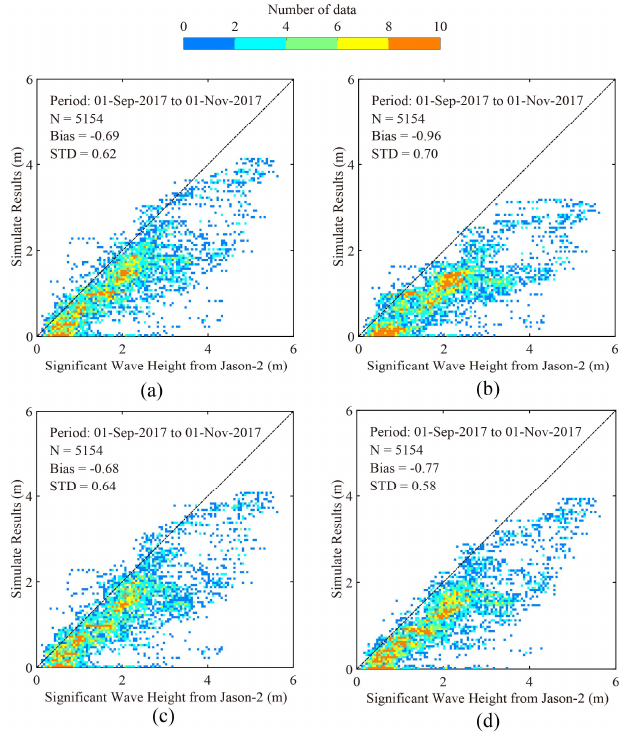
Figure 7. The comparisons between simulated results and measurements from altimeter Jason-2, in which the color represents the amount of data points. ( a ) Simulated results using the DIA package; ( b ) simulated results using the WRT package; ( c ) simulated results using the GMD1 package; ( d ) simulated results using the GMD2 package.